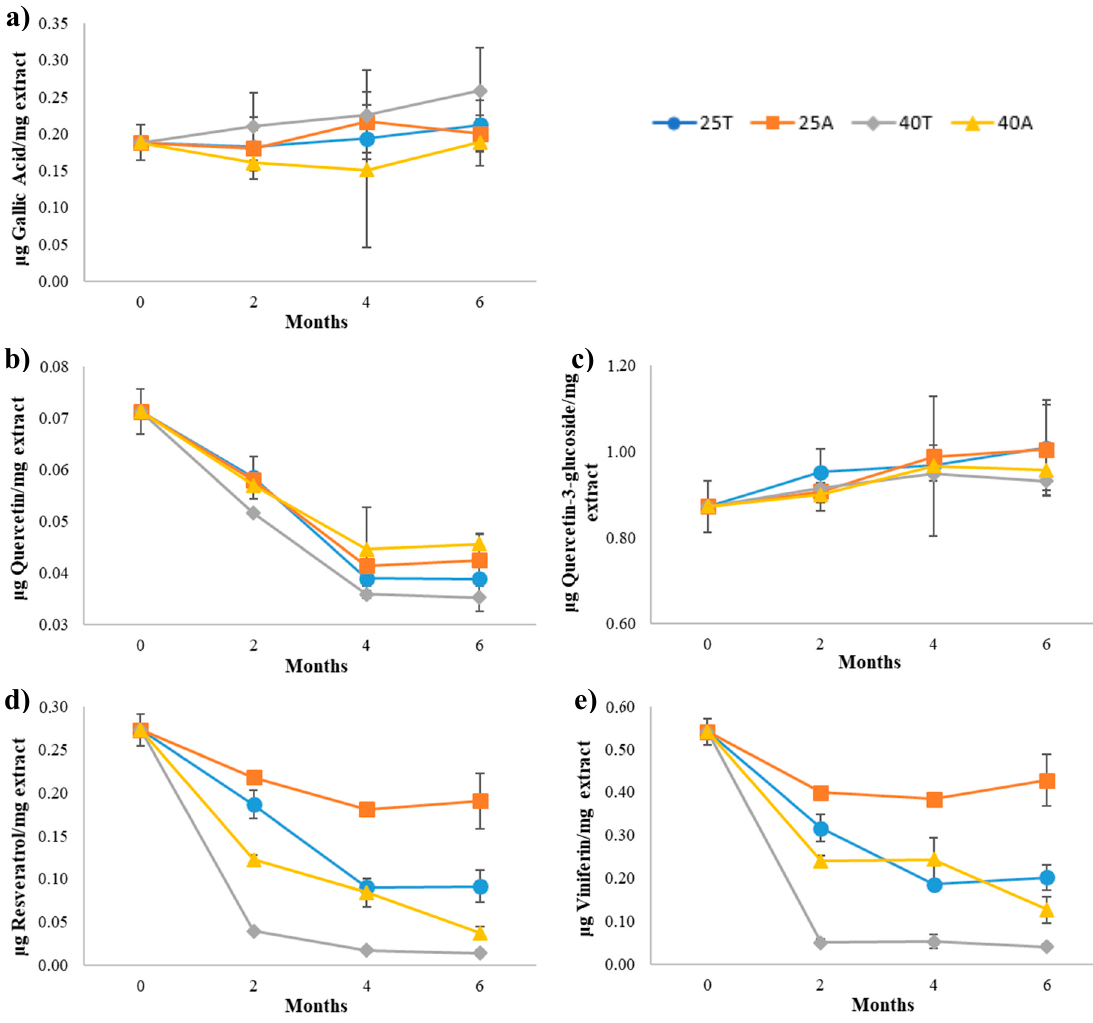
Figure 1. Concentration of gallic acid ( a ), quercetin ( b ), a quercetin derivative ( c ), resveratrol ( d ) and viniferin ( e ) during storage under different conservation conditions over 6 months. Here, 25T, samples conserved at 25 ° C in transparent vials; 25A, samples conserved at 25 ° C in amber vials; 40T, samples conserved at 40 ° C in transparent vials; 40A, samples conserved at 40 ° C in amber vials.